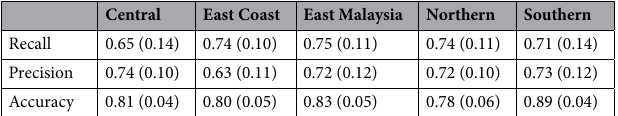
Table 9. Detailed Cross-Validation results with optimal parameter: Kernel = rbf,